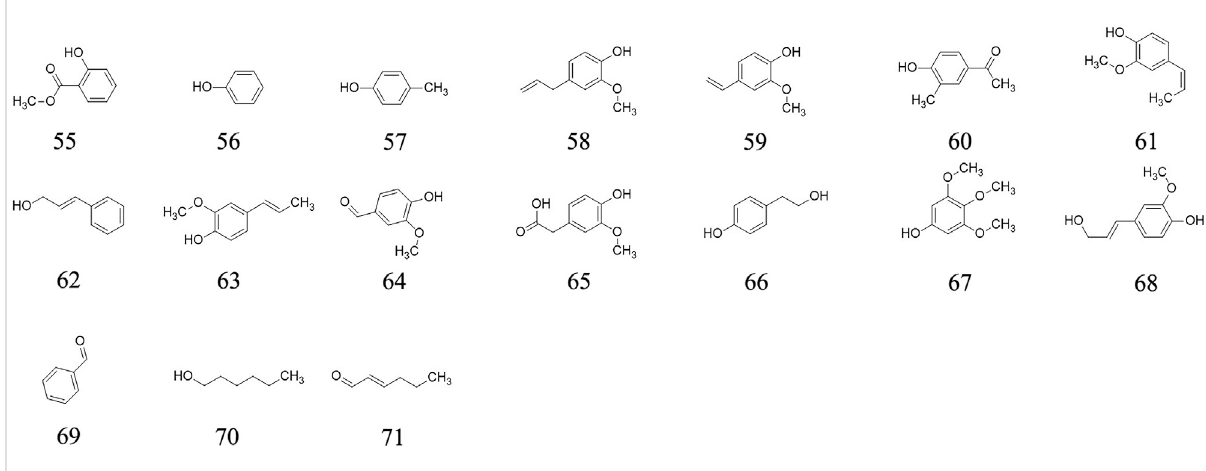
FIGURE 4 Phenolics and aldehydes determined from A. eriantha